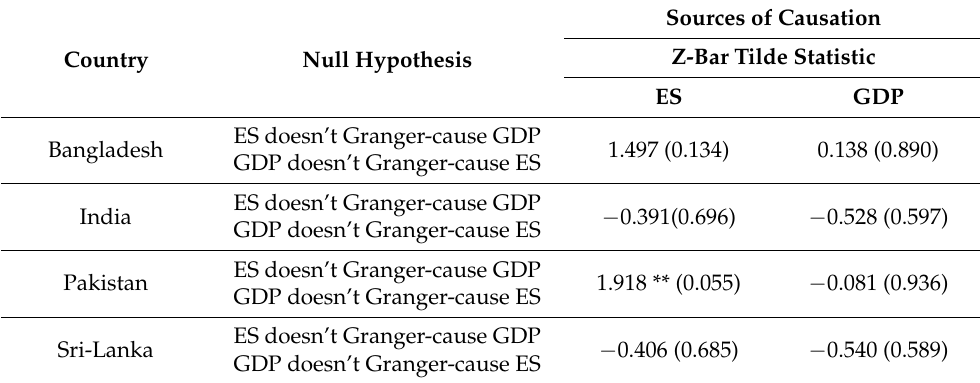
Sources of Causation Z-Bar Tilde Statistic ES GDP 1.497 (0.134) 0.138 (0.890) − 0.391(0.696) − 0.528 (0.597) 1.918 ** (0.055) − 0.081 (0.936) − 0.406 (0.685) − 0.540